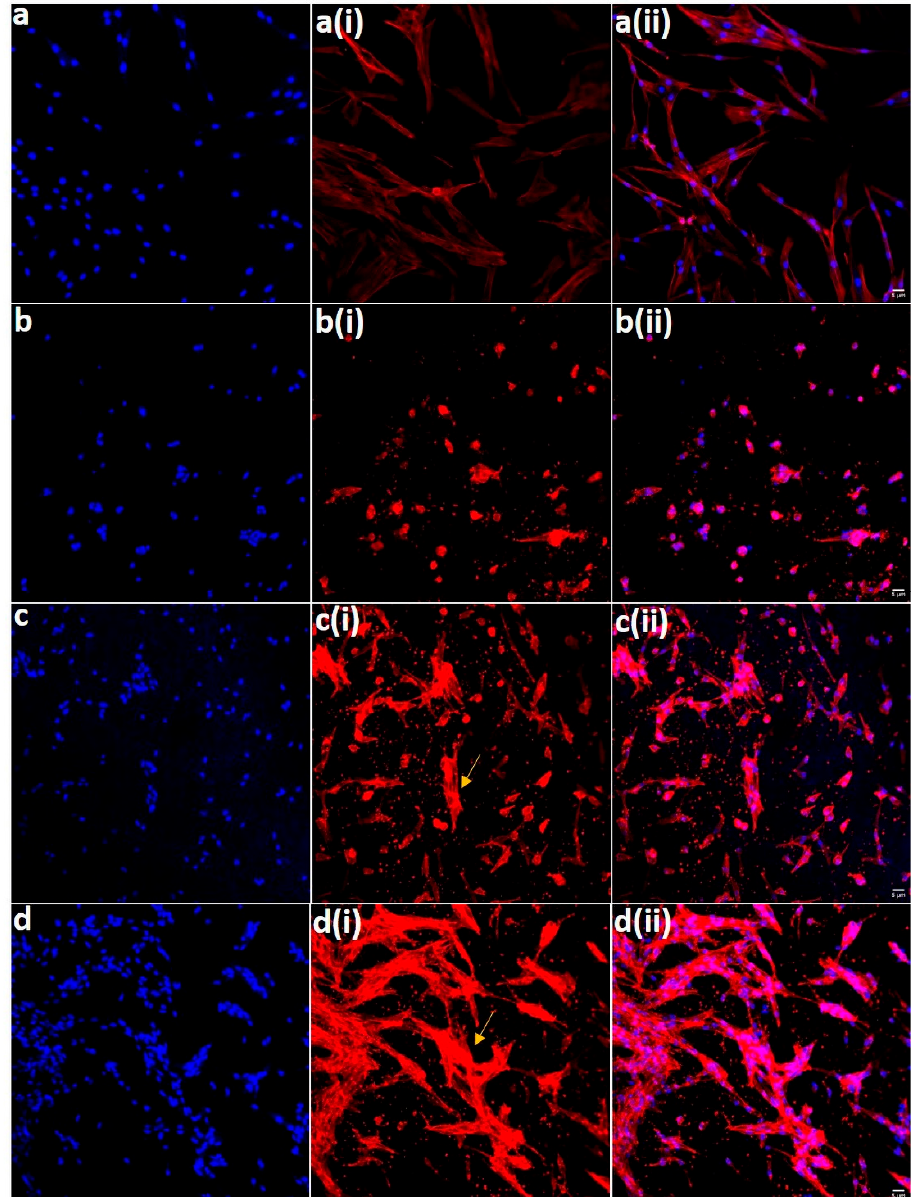
Figure 9. Representative confocal microscopic images of the cytoskeletal arrangement of hDPSCs on ( a ) control coverslips, ( b ) PCL, ( c ) PCLHA, and ( d ) PCLMTA. All the images in the first column represent the nuclear DAPI staining ( blue ), the second column represents the signal from actin ( red ), and the third column represents the merged signals. The spreading and cytoskeletal arrangement of hDPSCs in the PCLHA and PCLMTA are shown by arrows. The scale bar in the figure is 5 μ m.